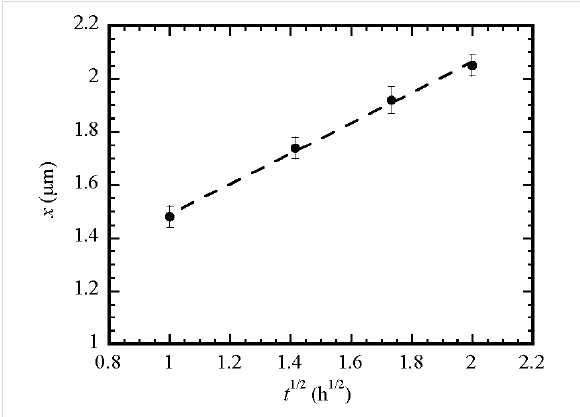
Figure 8: Migration distance of Ag atoms on the outmost surface of the TiO 2 nanotubes as a function of the time during the heat treatment at 400 °C.